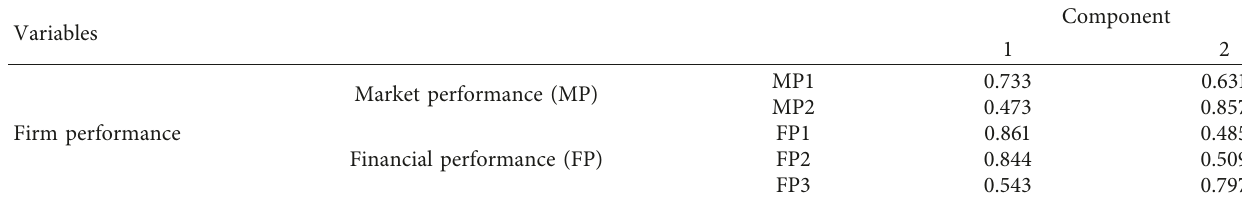
Table 7: Rotated component matrix of firm